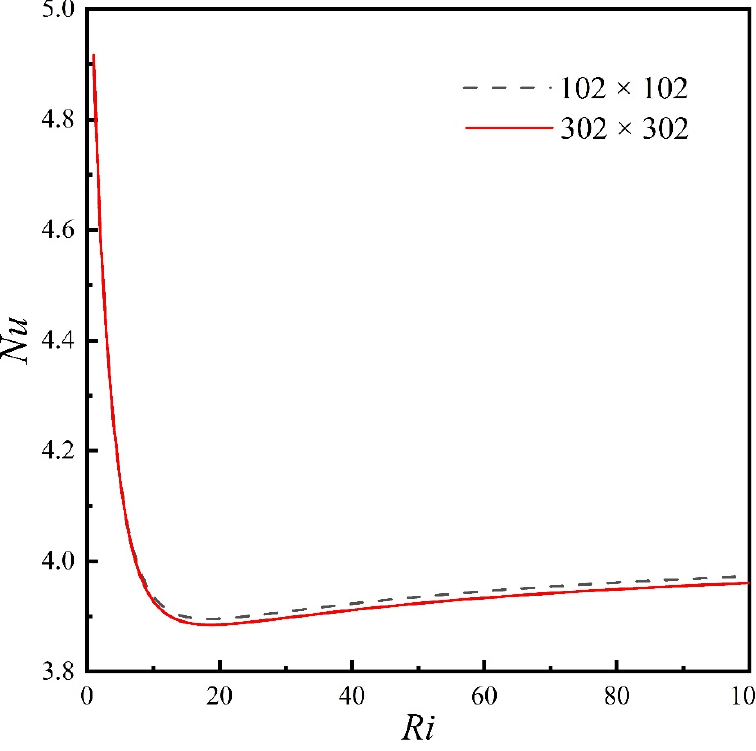
Figure 5. Grid independence of Nu number with Ri at Gr = 10 5 and Pr = 0.71. Table 2. Grid independence at different Da number and Ri number.